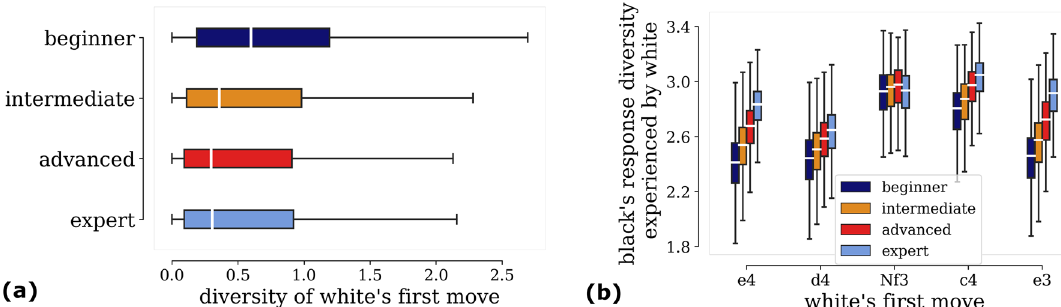
Figure 2. Diversity and specialization in the first move and black’s response. ( a ) Boxplots showing diversity (entropy) of first move by a player as white, calculated over all players individually and aggregated into the 4 different skill levels. Weak players start games with diverse collection of first move as white when compared to stronger players. ( b ) Boxplots showing diversity of black’s response experienced by white player, for each of white’s top 5 most played first moves— e 4, d 4, Nf 3, c 4 and e 3 (in descending order of popularity). As white, weakest players encounter lowest diversity in responses captured by low response entropy—for all of white’s most played opening moves, except